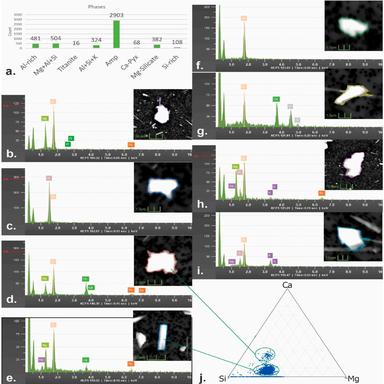
Example results from automated SEM analysis of amphibole reference material showing the variability in individual mineral phases detected (A) along with morphology of individual particles (B–I). Elemental data can be presented as ternary diagrams (J) to aid in identifying groups of minerals, such as pyroxenes (D) versus amphiboles (E).